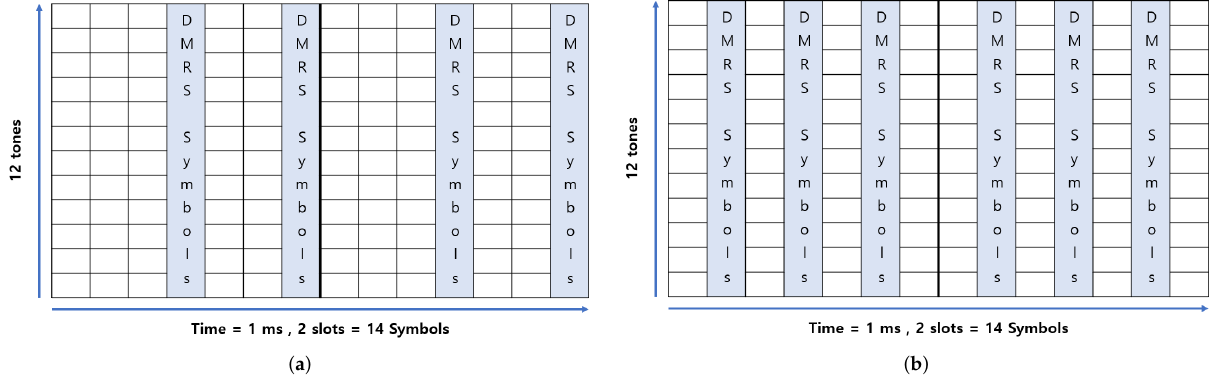
Figure 10. Proposed NB-IoT resource grid. ( a ) Two DMRS symbols per slot, ( b ) Three DMRS symbols per